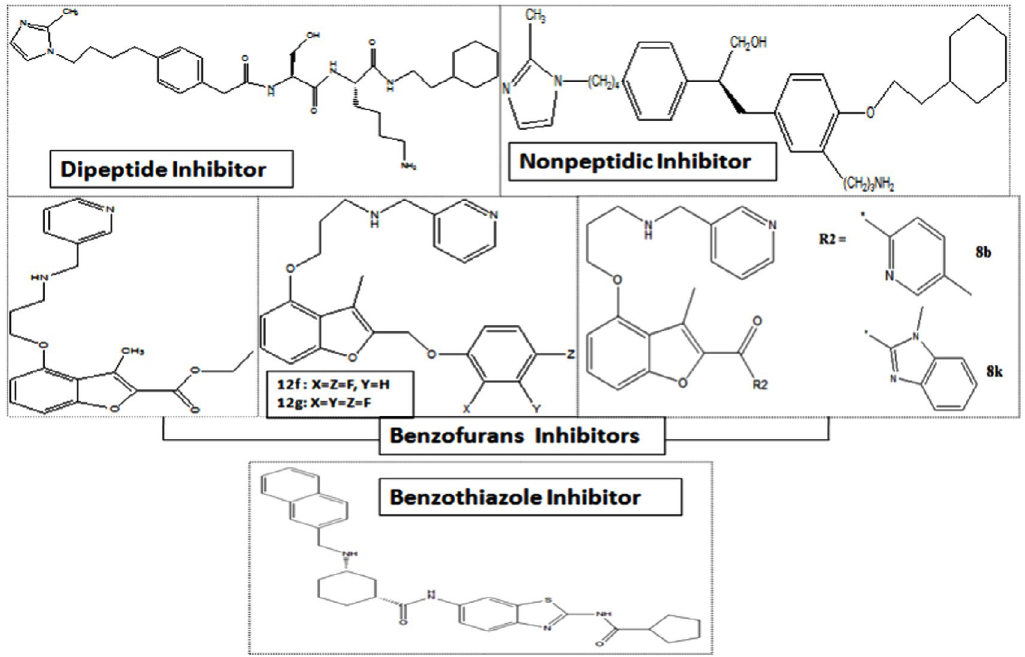
Fig. 5. Candida albicans NMT